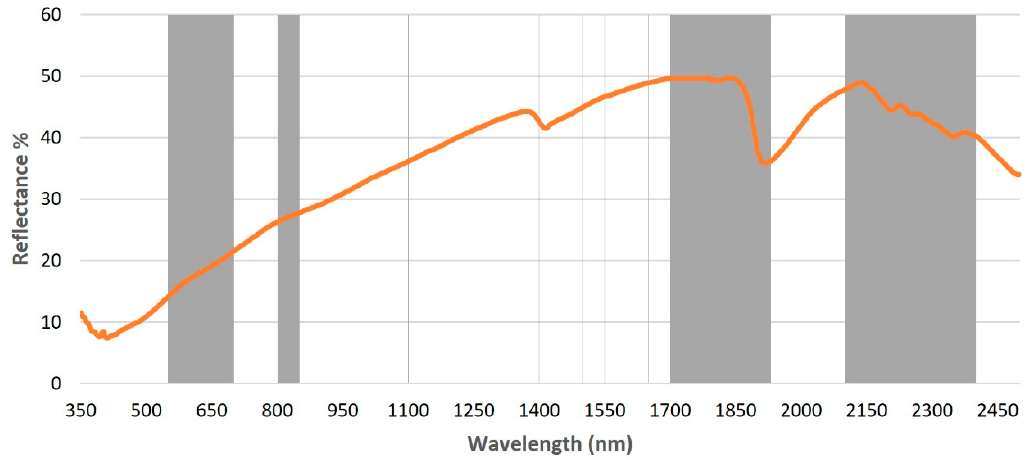
Figure 1. Spectral signature of a sandy loam soil with 5.43% organic carbon (OC) based on data from [28] and important wavelengths highlighted with grey color for soil OC (SOC) estimation according to bibliographic review.